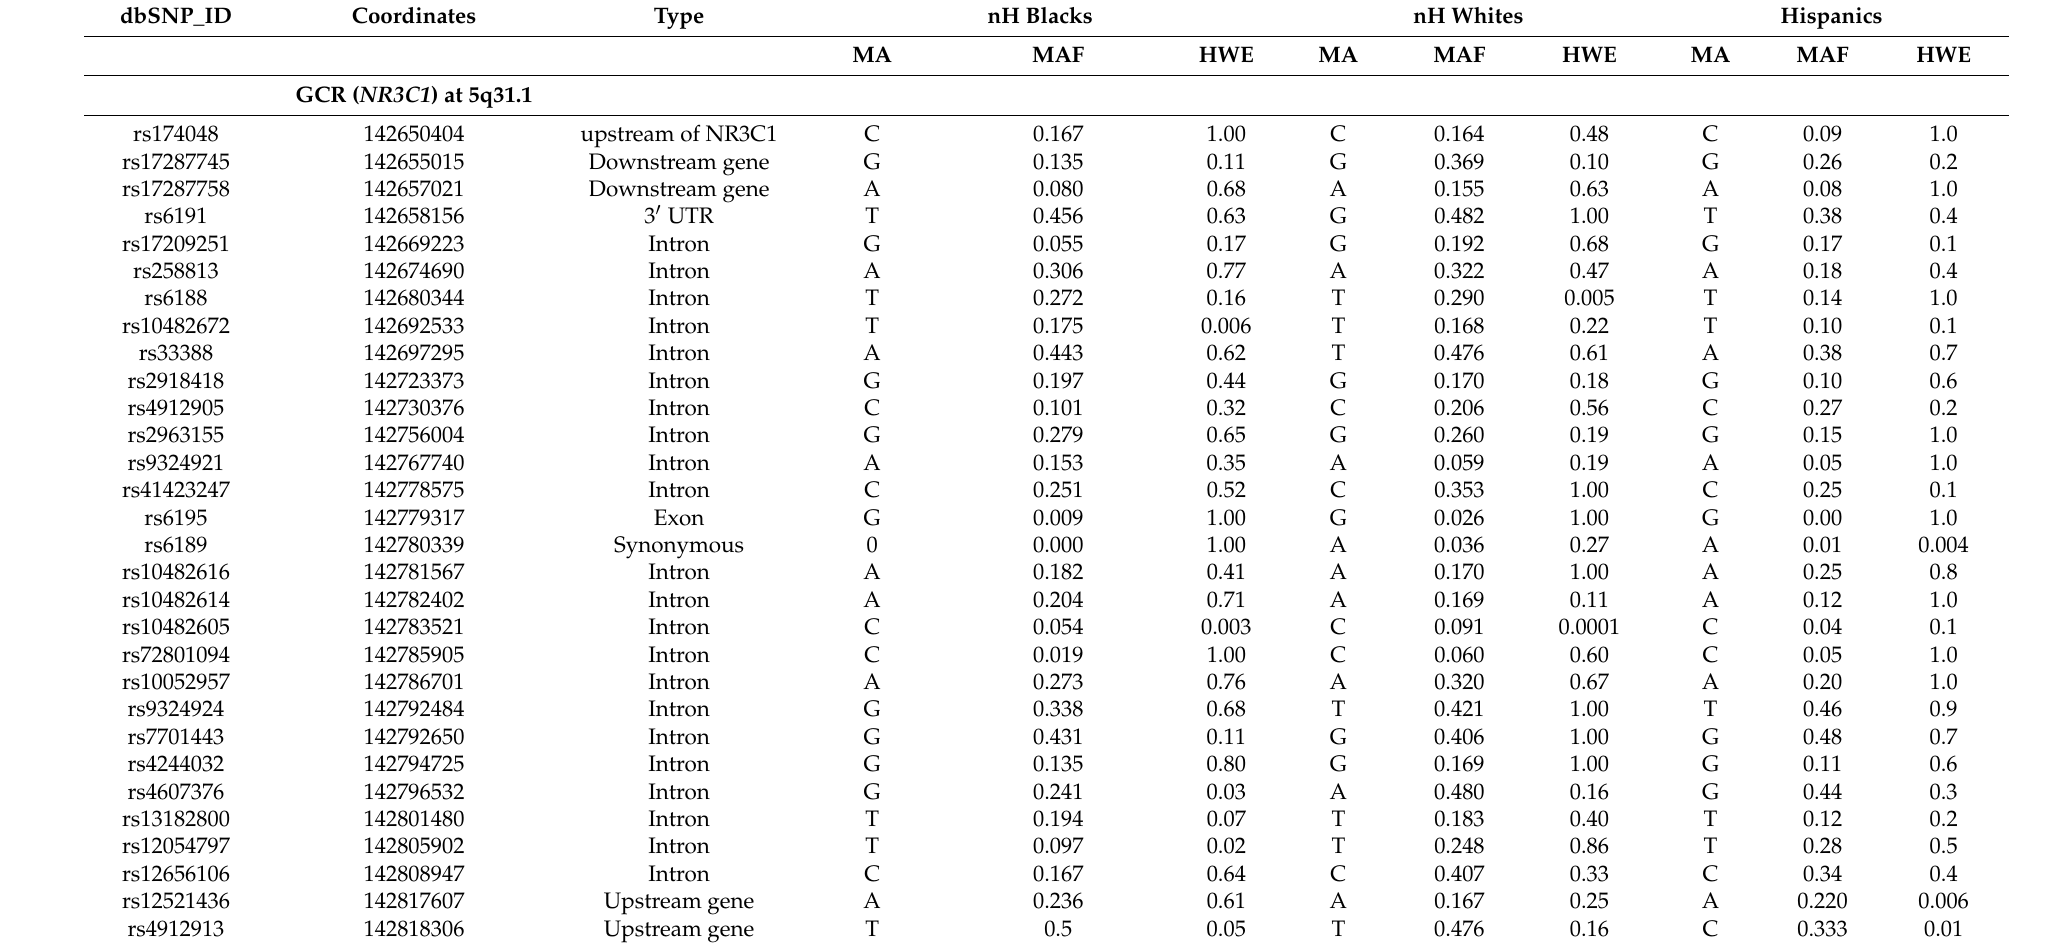
Table A2. Characteristics of studied